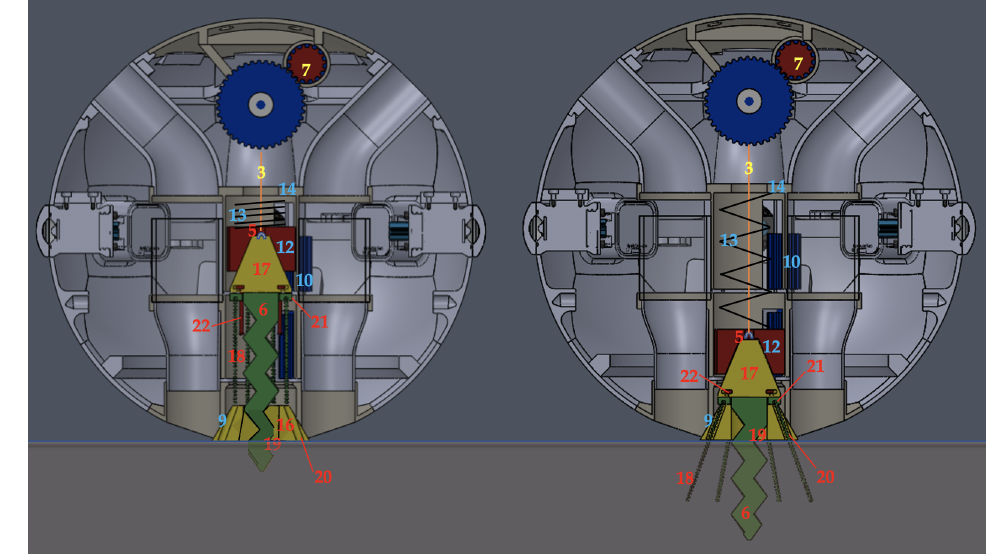
Figure 9. RAATM phase transition from inject ( left ) to rooted ( right ) position. Upon contact with the seabed, the anchor spike (6) is rotated further through the anchor plug (16), driving the anchor spike deeper into the sediment. To counter the reaction torque on the vehicle during augering, the vehicle must command an opposite yaw while maintaining downward force until the anchor cap (17) is fully seated in the anchor plug (16), unless the vehicle’s weight or use external structure is sufficient to resist this torque. As the anchor cap (17) is rotated, the spike extends further through the anchor plug (16) and deeper into the sediment. The swivel eyelet (5) at the top of the anchor spike prevents the tether (3) from twisting. The anchor cap (17) presses down on the wire root ring (21), freely rotating over the non-rotating ring and forcing the wire root array (18) through the root tunnels (20) as the root ring retention rods (22) drive into their corresponding wells within the anchor plug (16). The wire root bristles are driven into the sediment around the base of the anchor plug. When the anchor cap coupler (12) reaches the aft stops within the anchor sleeve, the anchor assembly is fully